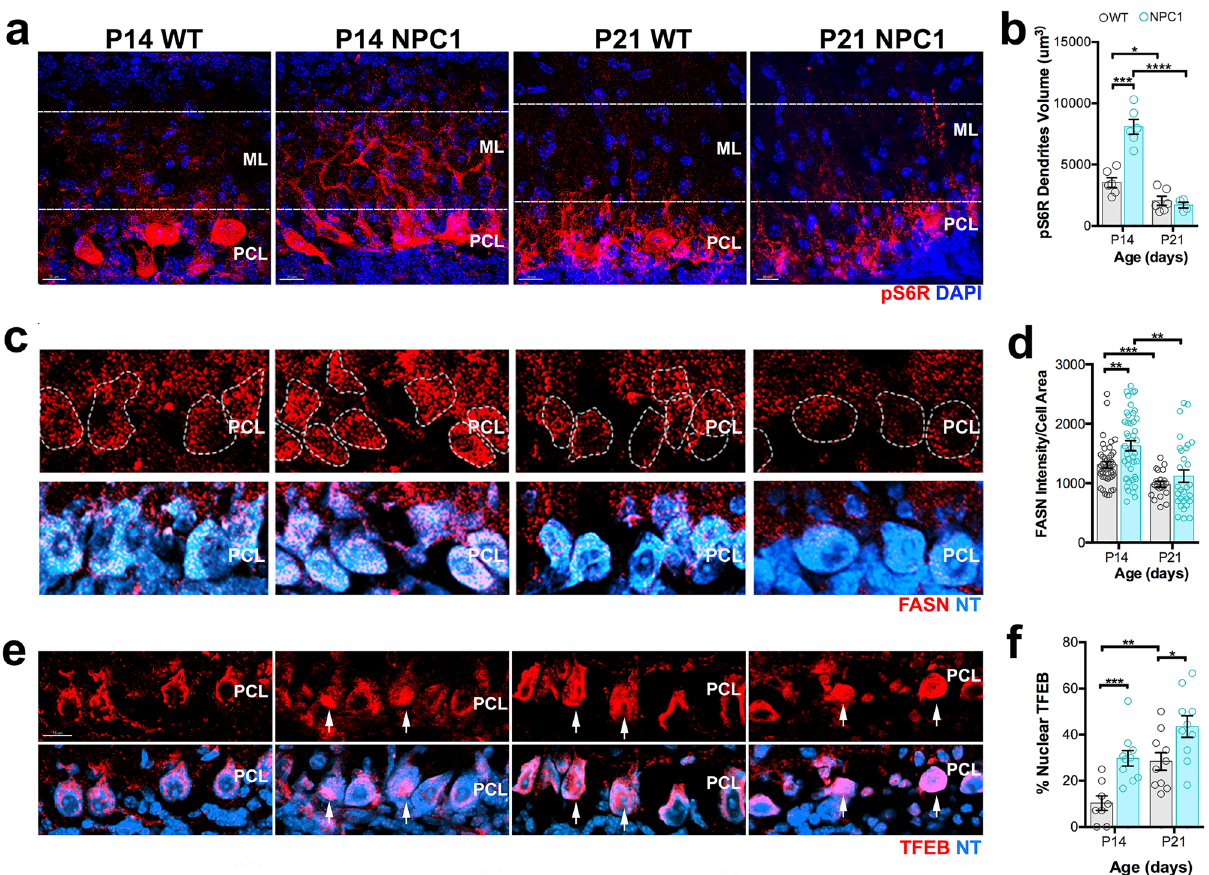
Figure 5. Simultaneous overactivation of the mTORC1 pathway and TFEB occurs in PCs from P14 Npc1 nmf164 mice. ( a ) Confocal images showing pS6R immunoreactivity in the cerebellar PCL and ML of P14 and P21 WT and Npc1 nmf164 mice. Dotted lines indicate the region used for quantitative analysis. ( b ) Quantitative analysis of the total volume of pS6R in PC dendrites from WT and Npc1 nmf164 mice at P14 and P21. Data are presented as mean ± SEM, n = 3 mice/genotype/age, 2 images/mouse. ( c ) Confocal images showing FASN immunoreactivity and NeuroTrace (NT) staining in the cerebellar PCL of P14 and P21 WT and Npc1 nmf164 mice. ( d ) Quantitative analysis of FASN fluorescence intensity in NT + PCs from WT and Npc1 nmf164 mice at P14 and P21. Data are presented as mean ± SEM, n = 10 cells/mouse from 4 mice/genotype/age. ( e ) TFEB immunoreactivity in PCs from WT and Npc1 nmf164 mice at P14 and P21; nuclear localization of TFEB is indicated by white arrows. ( f ) Percentage of PCs showing nuclear translocation of TFEB in WT and Npc1 nmf164 mice at P14 and P21. Data are presented as mean ± SEM, n = 4 mice/genotype/age, 2–3 images/mouse. *P < 0.05, **P < 0.001, ***P < 0.001, ****P < 0.0001. Scale bars: ( a ) and ( c ) 20 μm, ( e ) 15